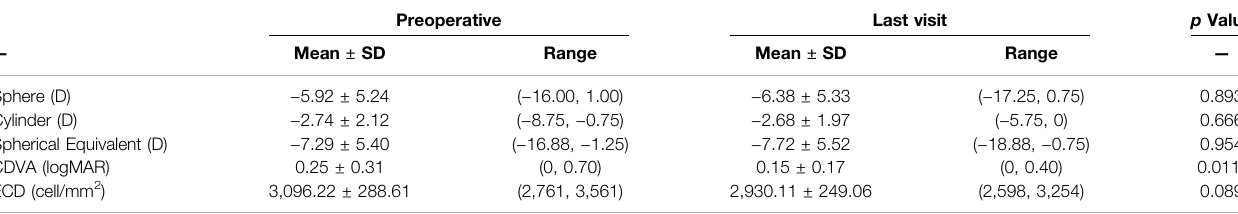
TABLE 1 | Refraction outcomes and endothelial cell